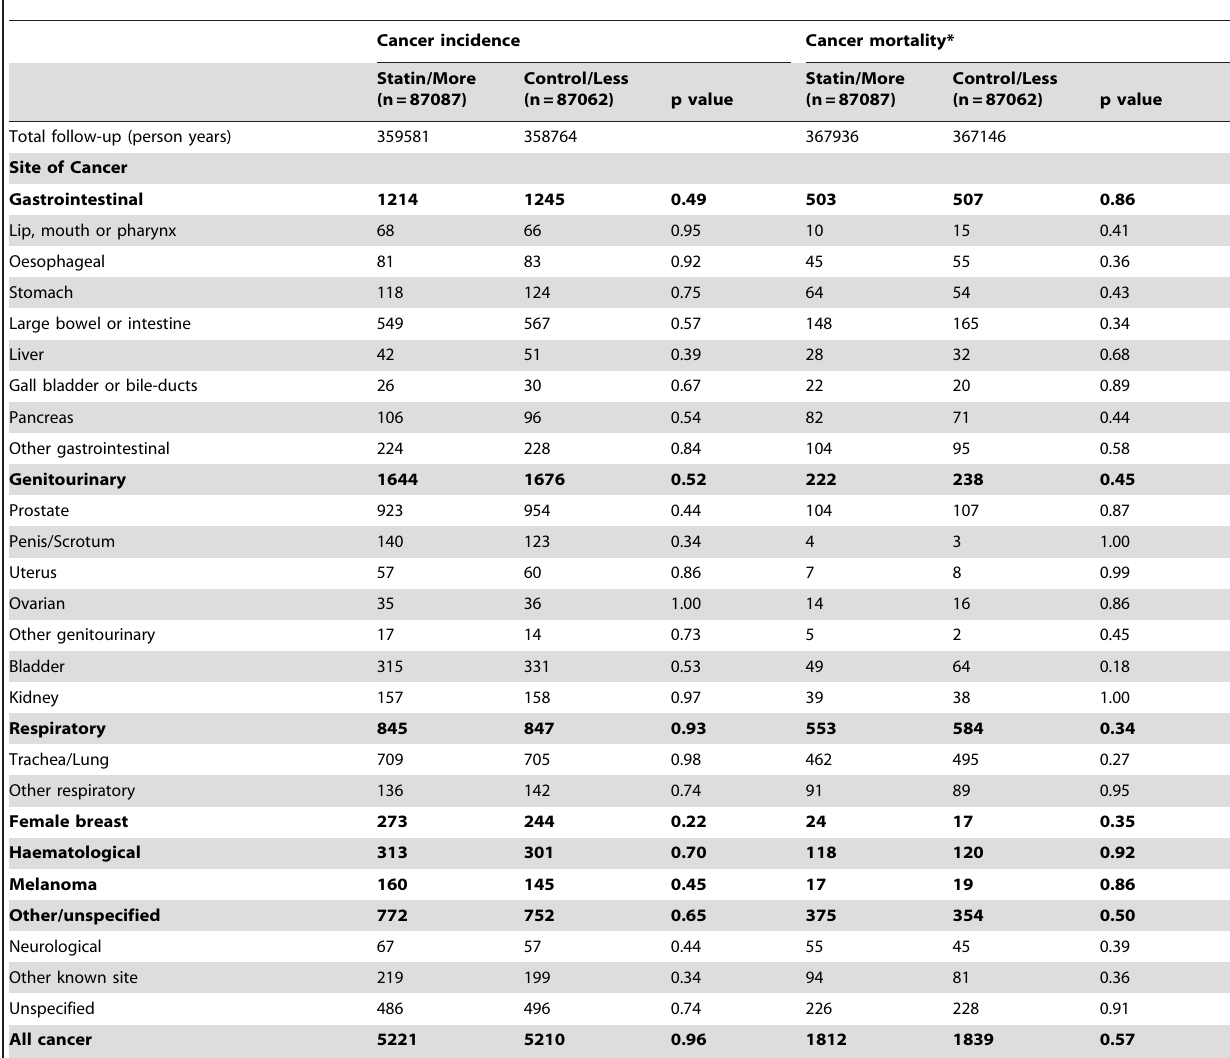
Table 2. Cancer incidence and cancer mortality in all 27 trials, by site.